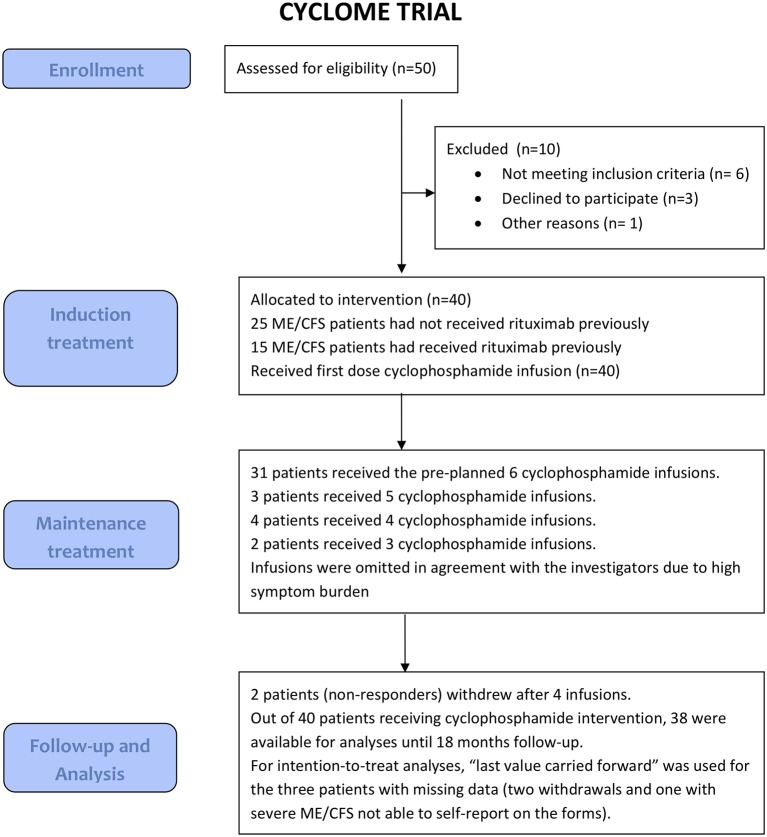
Flow diagram of enrollment, treatment and follow-up in the CycloME study.